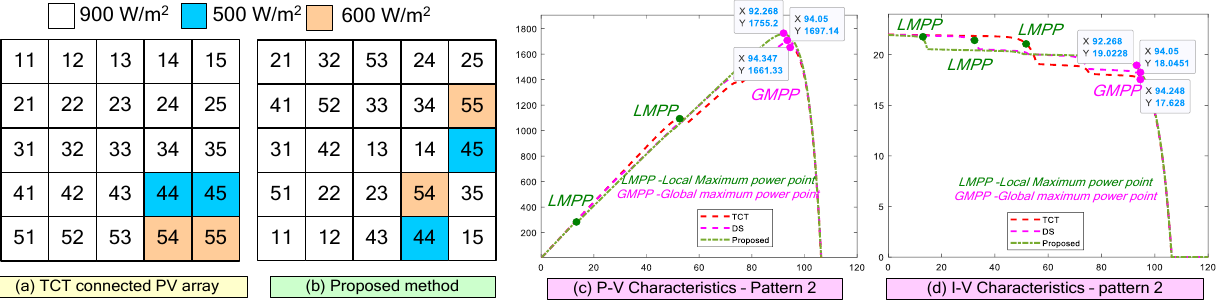
LMPP -Local Maximum power point GMPP -Global maximum power point Figure 4. Shade pattern 2: ( a ) TCT arrangement, ( b ) Proposed arrangement, ( c ) P – V characteristics, ( d ) I – V characteristics.